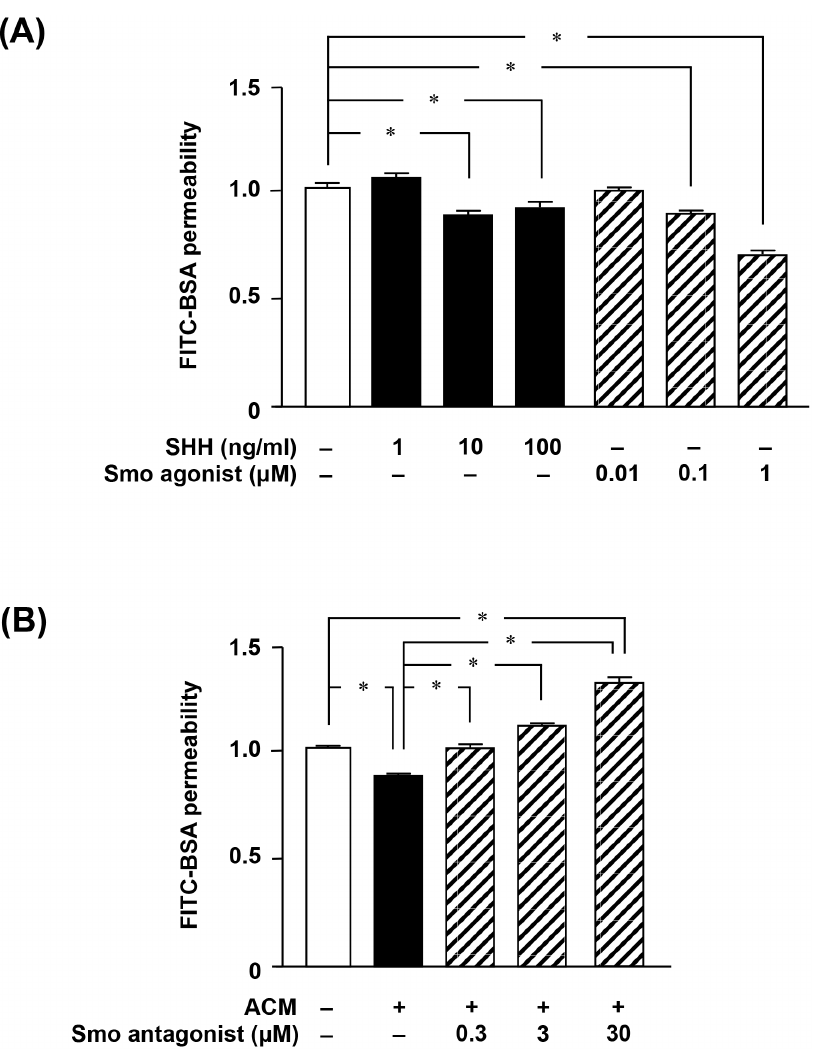
Figure 3. SHH signaling is critical for maintenance of BBB integrity. (A) MBEC4 cells were treated with SHH or the Smo agonist purmorphamine for 24 h. (B) MBEC4 cells were treated with ACM or the Smo antagonist cyclopamine for 24 h. FITC-BSA was loaded onto the luminal side of the insert for 1 h, and then the FITC-BSA levels on the abluminal side were analyzed. All quantitative data are expressed as means 6 SEM (n=5), normalized to the corresponding values from untreated cells. *, p , 0.001.